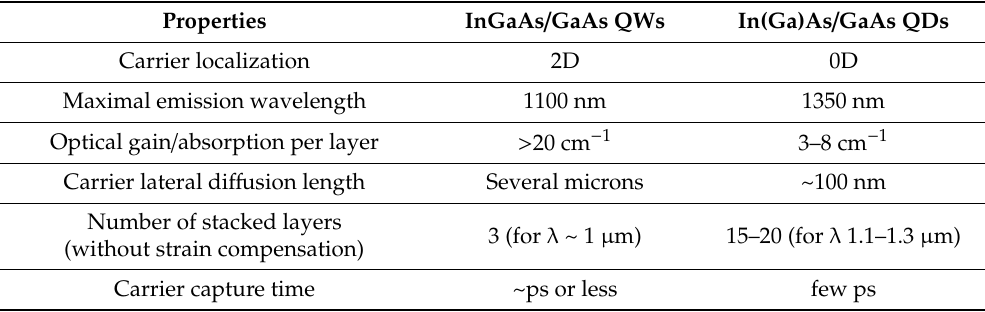
Table 1. Comparison of the characteristics of quantum wells and quantum